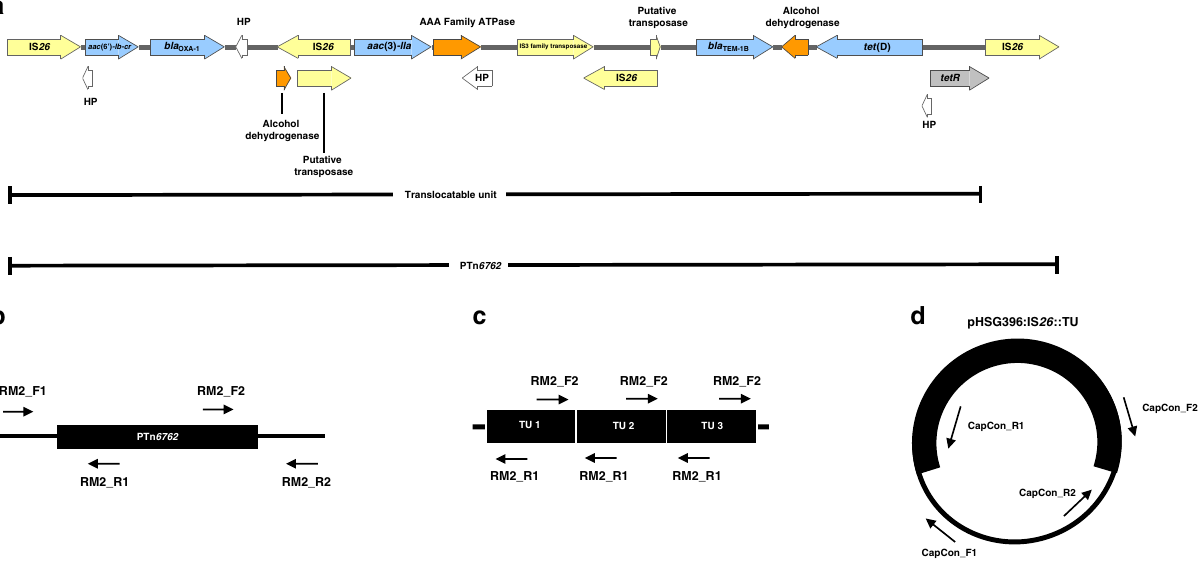
Fig. 2 Schematics of the pseudo-compound transposon PTn 6762 , translocatable unit and positions of primers used in this study. Schematic showing ( a ) the characterisation of PTn 6762 (HP = hypothetical protein) and the position of the primer pairs to detect ( b ) the junctions of the PTn 6762 in the chromosome, ( c ) the presence of the tandem array of TUs in the chromosome and ( d ) the junctions of the insertion of the TU into pHSG396:IS 26 .